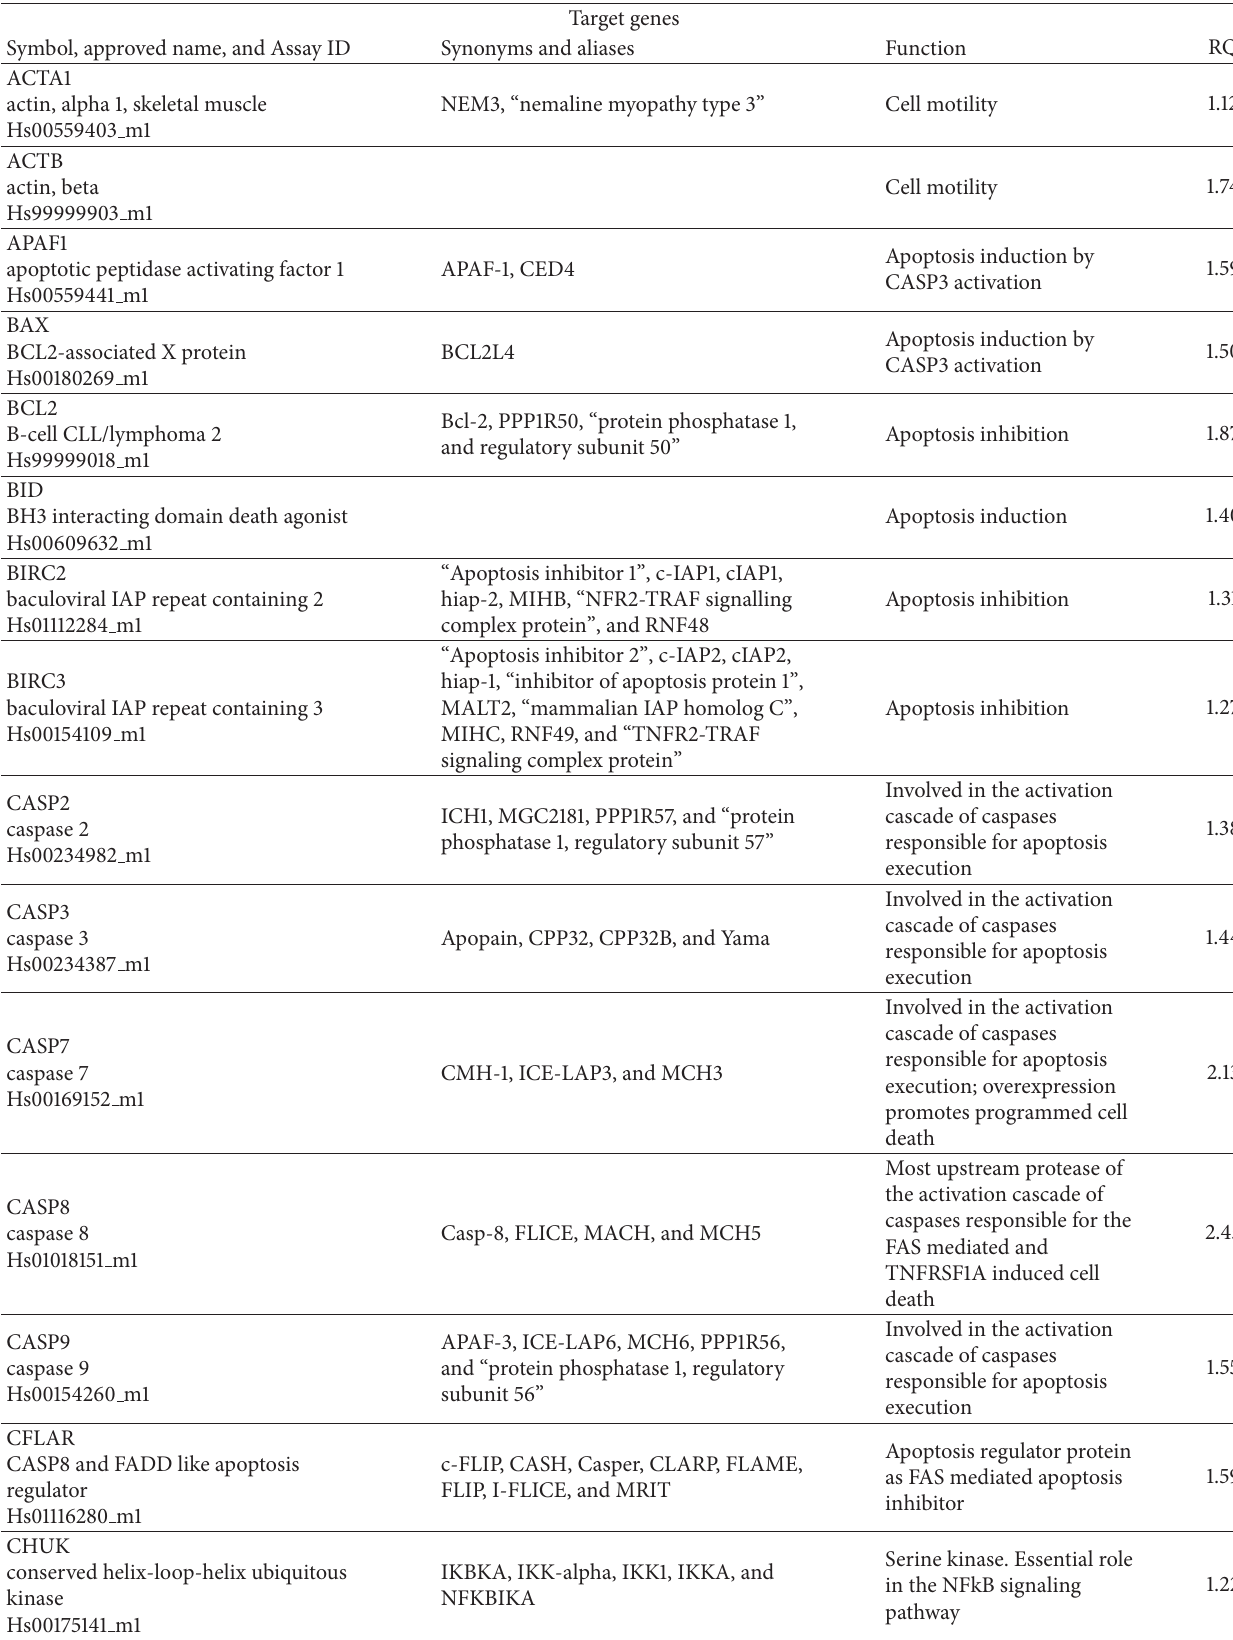
Table 1: Array target genes: apoptosis through death receptors in TLE(HS). Target